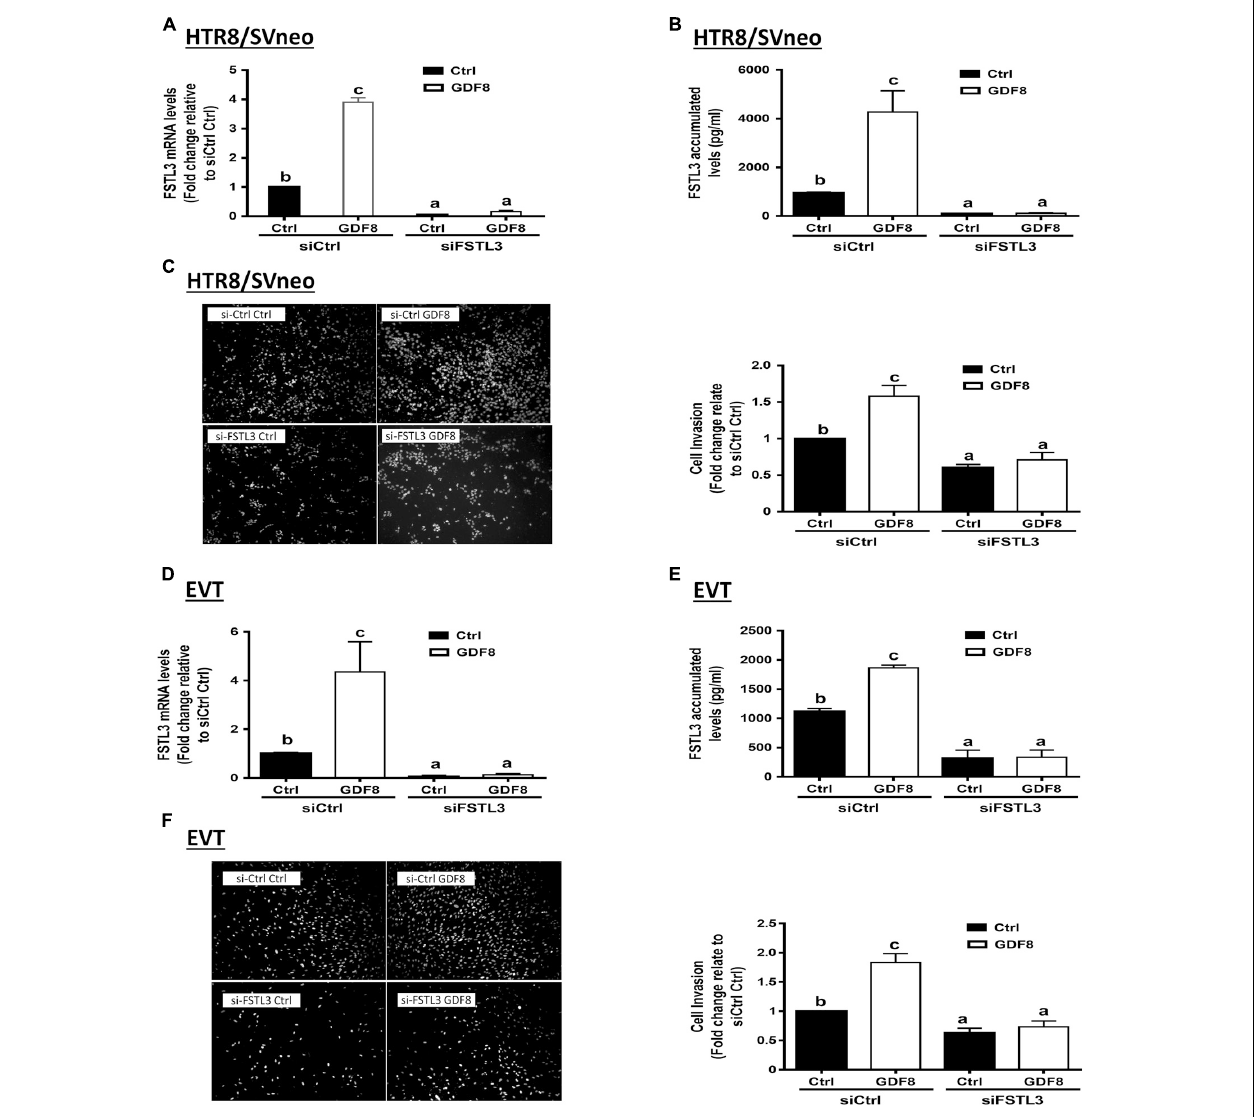
FIGURE 3 | Follistatin-like 3 (FSTL3) mediates growth differentiation factor 8 (GDF8)-induced cell invasion in HTR8/SVneo and primary EVT cells. A,B,D , and E : HTR8/SVneo (A,B) or primary EVT (D,E) cells were transfected for 24 h with 20 nM non-targeting control siRNAs (siCtrl) or 20 nM siRNAs targeting FSTL3 (siFSTL3), after which the cells were treated with the vehicle control (Ctrl) or 25 ng/mL GDF8 for 24 h; the mRNA (A,D) and accumulated (B,E) levels of FSTL3 were examined using RT-qPCR and ELISA, respectively. C,F : HTR8/SVneo (C) or primary EVT (F) cells were transfected for 24 h with 20 nM siCtrl or 20 nM siFSTL3, after which the cells were treated with Ctrl or 25 ng/mL GDF8 for 24 h; cell invasion was examined using the Matrigel-coated transwell assay. The results are displayed as the mean ± SEM of at least three independent experiments, and the values with different letters are significantly different ( P <